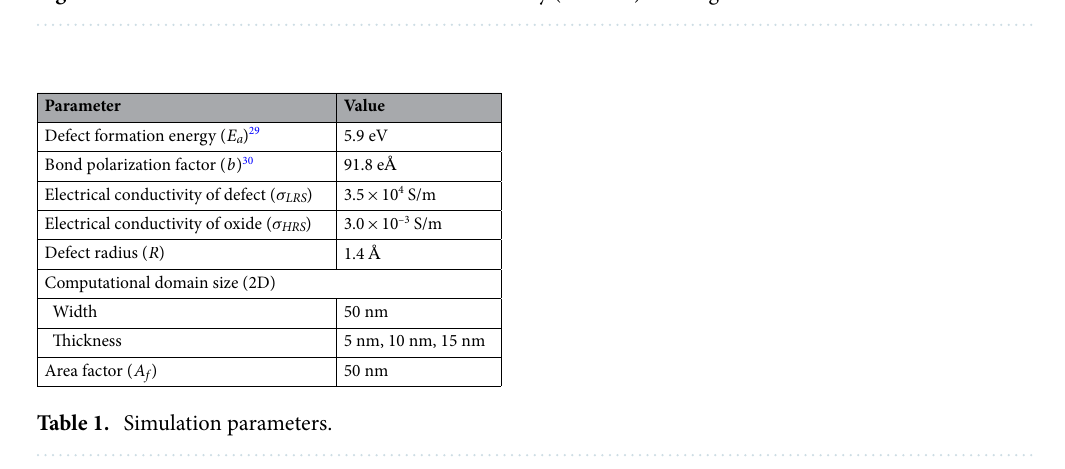
Figure 2. Flowchart for resistive random-access memory (ReRAM) forming simulation.